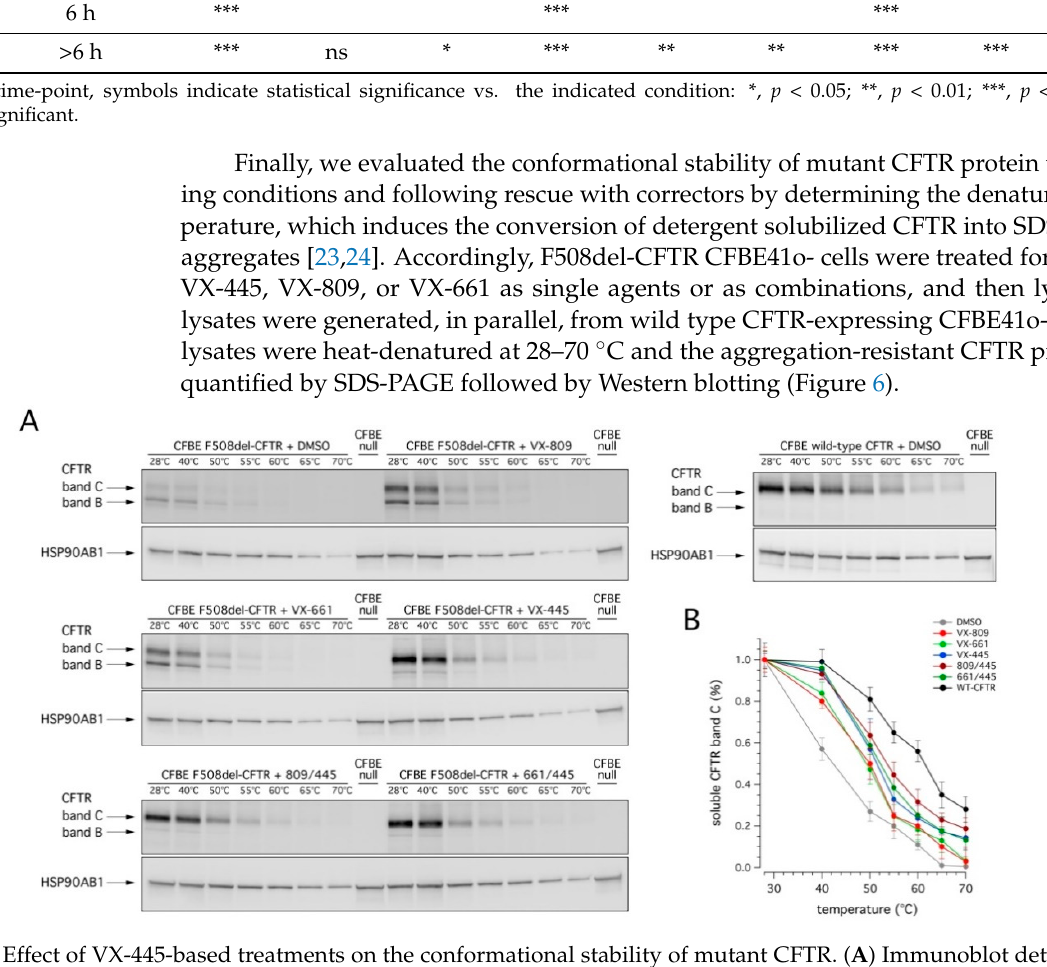
Figure 6. Effect of VX ‐ 445 ‐ based treatments on the conformational stability of mutant CFTR. ( A ) Immunoblot detection of CFTR in whole lysates derived from wild ‐ type or F508del ‐ CFTR expressing CFBE41o ‐ cells treated with vehicle alone (DMSO), or (for mutant CFTR only) with VX ‐ 445 (3 μ M), VX ‐ 809 (3 μ M), or VX ‐ 661 (10 μ M) as single agents or combinations, following heat ‐ denaturation at 28–70 °C. For comparison, whole lysates derived from parental CFBE41o ‐ cells (null cells) are also shown as controls for antibody specificity. ( B ) Quantification of aggregation ‐ resistant (soluble) CFTR band C by densitometry, normalized by HSP90AB1 expression (means ± SD; n = 3).